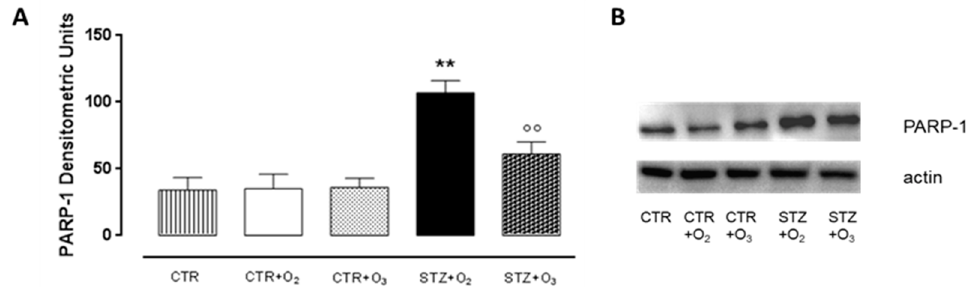
Figure 5. PARP-1 pancreatic levels. Western blot analysis of PARP-1 pancreatic levels after one week of STZ: PARP-1 levels were significantly reduced in STZ rats administered with 10 treatments of 150 µg/kg of O 2 /O 3 mixture compared to STZ rats administered with 1.5 mL O 2 ( p < 0.01). Results are expressed as densitometric units ± s.e.m. of five experiments. CTR = saline-treated rats; CTR + O 2 = oxygen-treated rats; CTR + O 3 = ozone-treated rats; STZ + O 2 = oxygen-treated STZ rats; STZ + O 3 = ozone-treated STZ rats. ** p < 0.01 vs. CTR + O 3 ; °° p < 0.01 vs. STZ + O 2 .